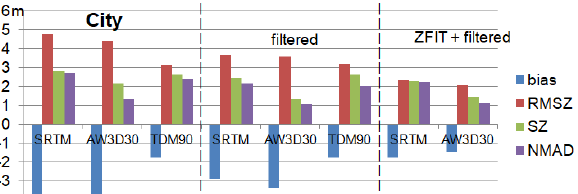
Figure 18. Accuracy results in open areas of test site